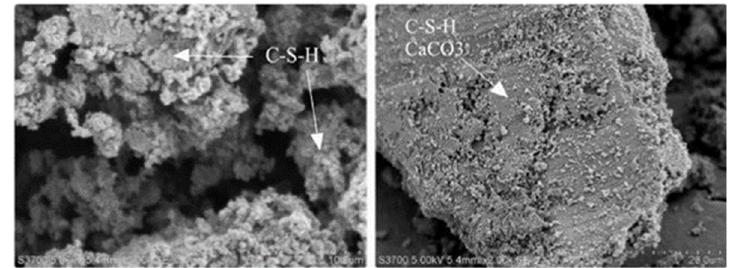
Figure 2. SEM observation of cement paste before ( left ) and after ( right ) carbonation [55].